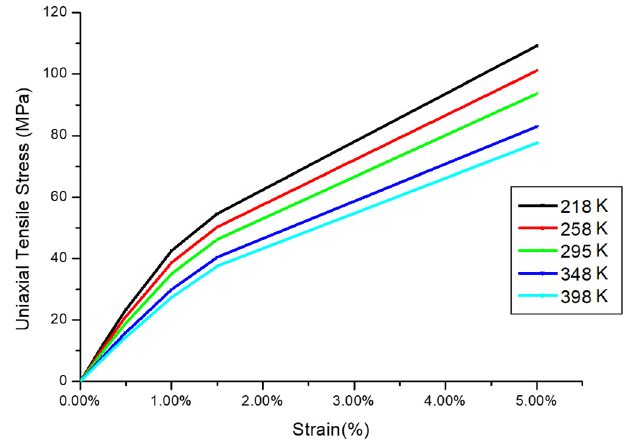
Figure 6. Nonlinear mechanical response of solder joint (63Sn/37Pb) with different temperatures